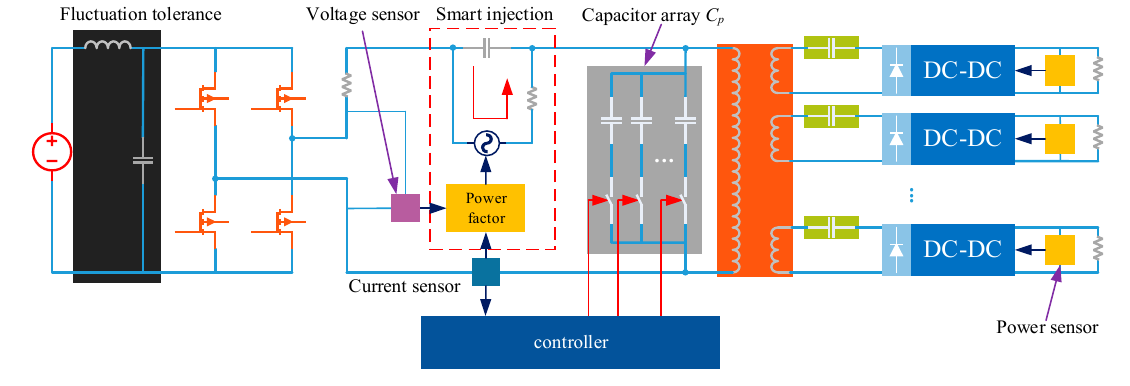
Figure 4. Equivalent circuit.